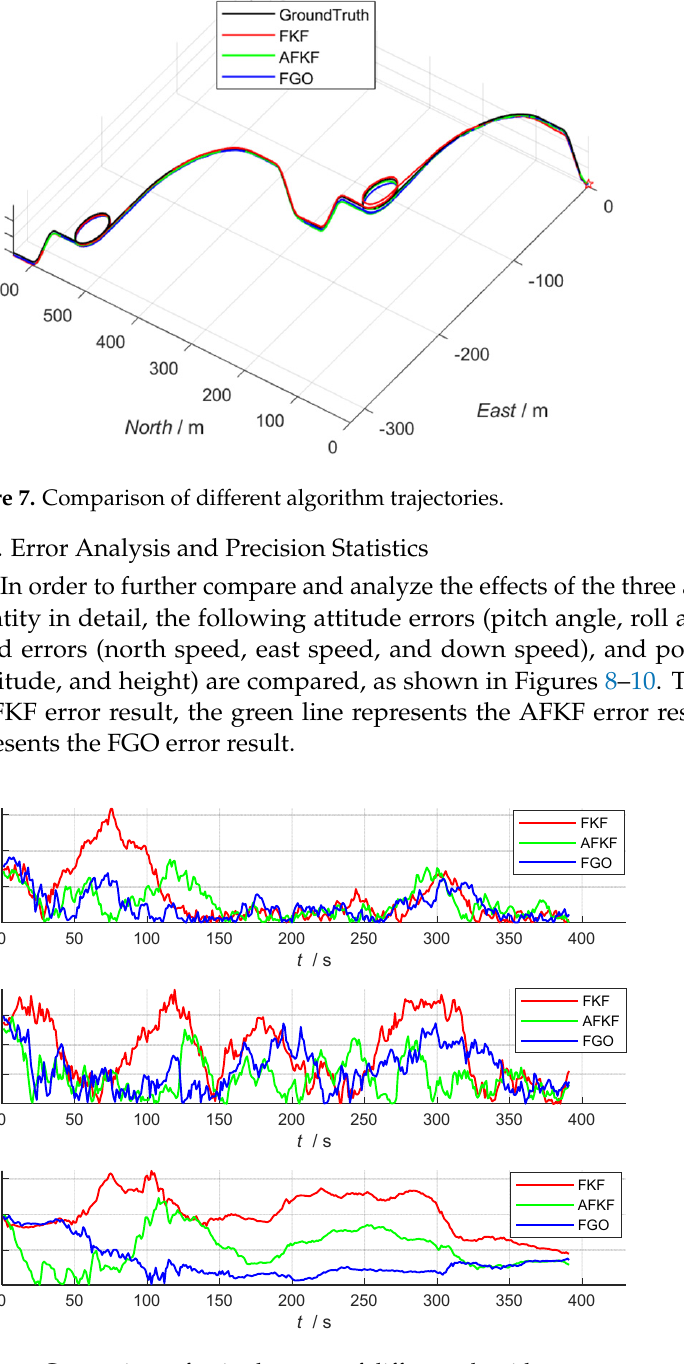
Figure 8. Comparison of attitude errors of different algorithms.